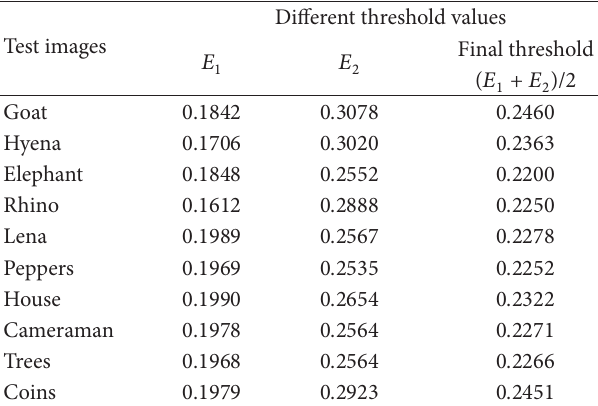
Table 2: Threshold values obtained for different test images. Test